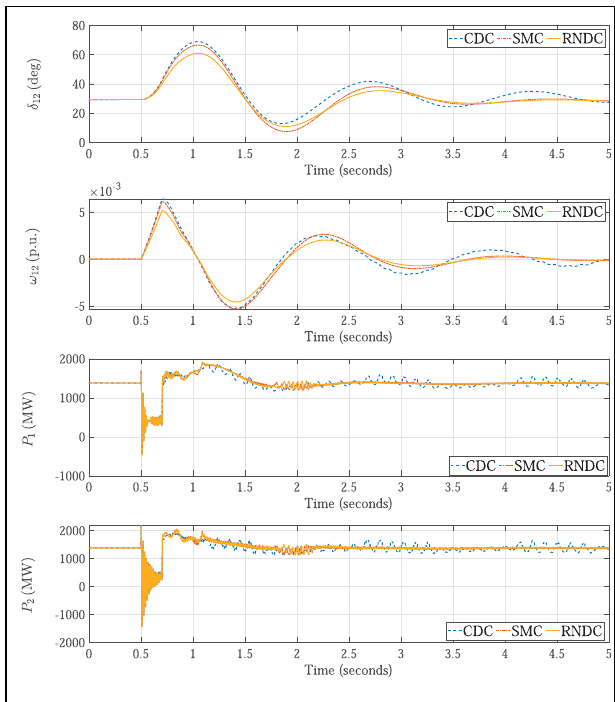
FIGURE 5 | Simulation results obtained in the case where a three-phase-to-ground fault occurs close to the Area 1 power